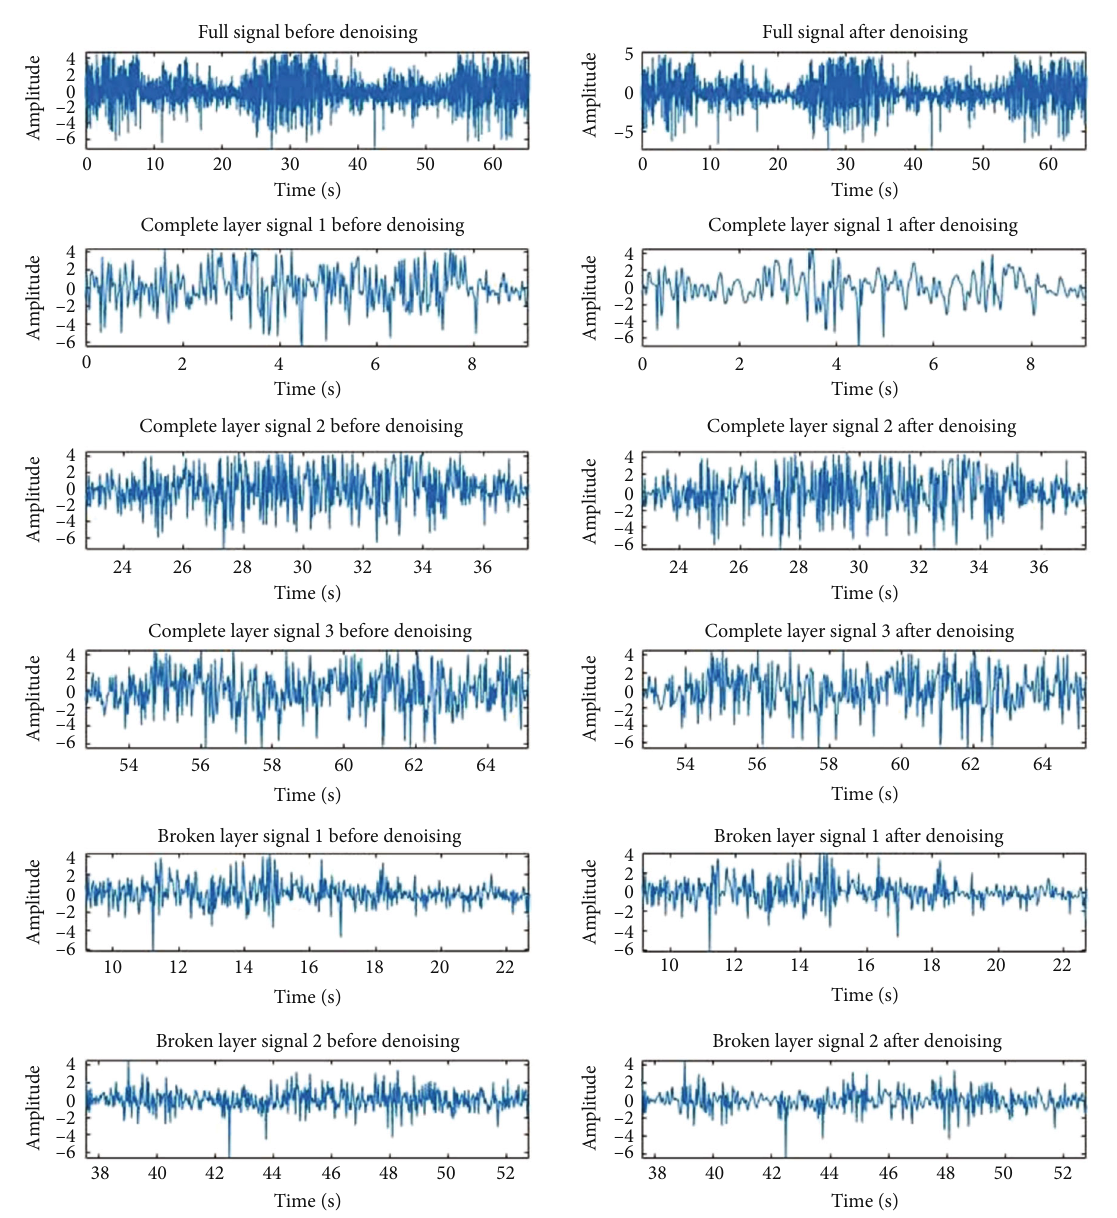
Figure 12: Denoising e ff ect diagram of borehole 6 by rigrsure threshold